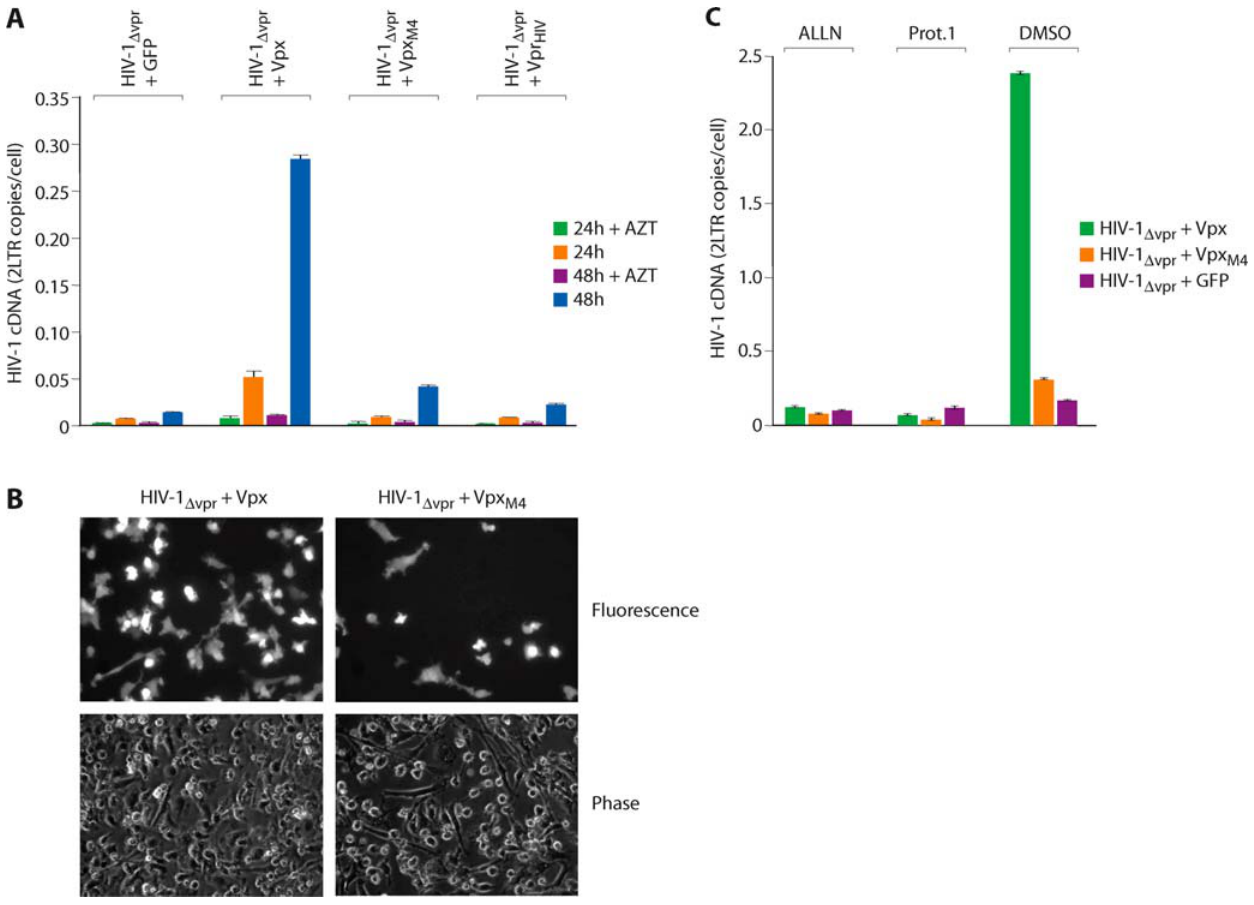
Figure 6. Ubiquitylation is required for enhancement of HIV-1 infectivity in macrophages. (A) Infectivity of HIV-1 variants packaging wild type or lysine-mutant Vpx proteins. Wild type HIV-1 Vpr, SIV Vpx or lysine mutant Vpx (Vpx M4 ) proteins were packaged in HIV-1 D vpr and infectivity of those viruses was assessed on macrophages. Viral cDNA synthesis was evaluated 24 and 48 h post-infection. (B) Infection of macrophages with HIV- 1 D Vpr GFP variants packaging wild type or mutant Vpx proteins. Cells were visualized 48 h post-infection. ( C) The ability of Vpx to enhance permissivity of macrophages to HIV-1 infection requires a functional proteasome. Macrophages were treated with the proteasome inhibitors ALLN or proteasome inhibitor 1 (Prot. 1) or with DMSO as a control. Those cells were then infected with HIV-1 D vpr variants which had packaged wild type or lysine mutant Vpx proteins. The level of viral infection (2-LTR cDNA) was determined 24 h post-infection by PCR (error bars are s.d. of 3 replicate PCRs of a single DNA sample.)